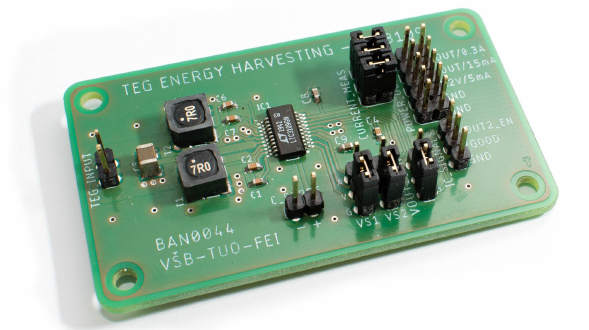
Figure 7. Experimental printed circuit board equipped by LTC3109 DC/DC